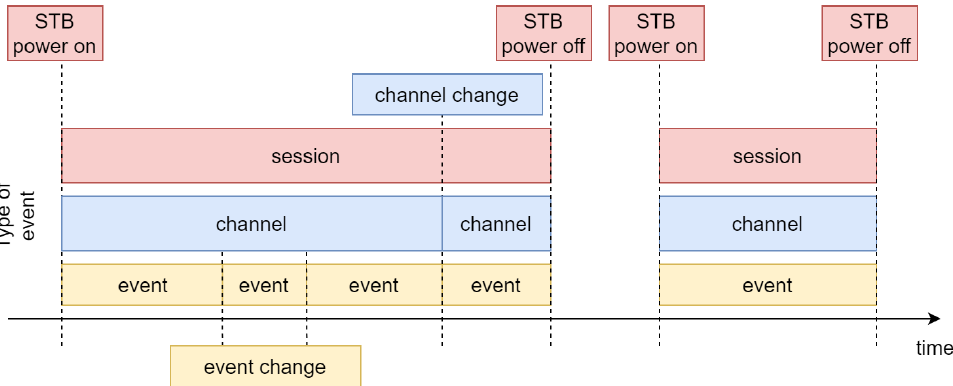
Figure 11. Timeline for session assessment. The customer can watch many events on a single TV channel. The session begins when the STB power is on, and lasts until